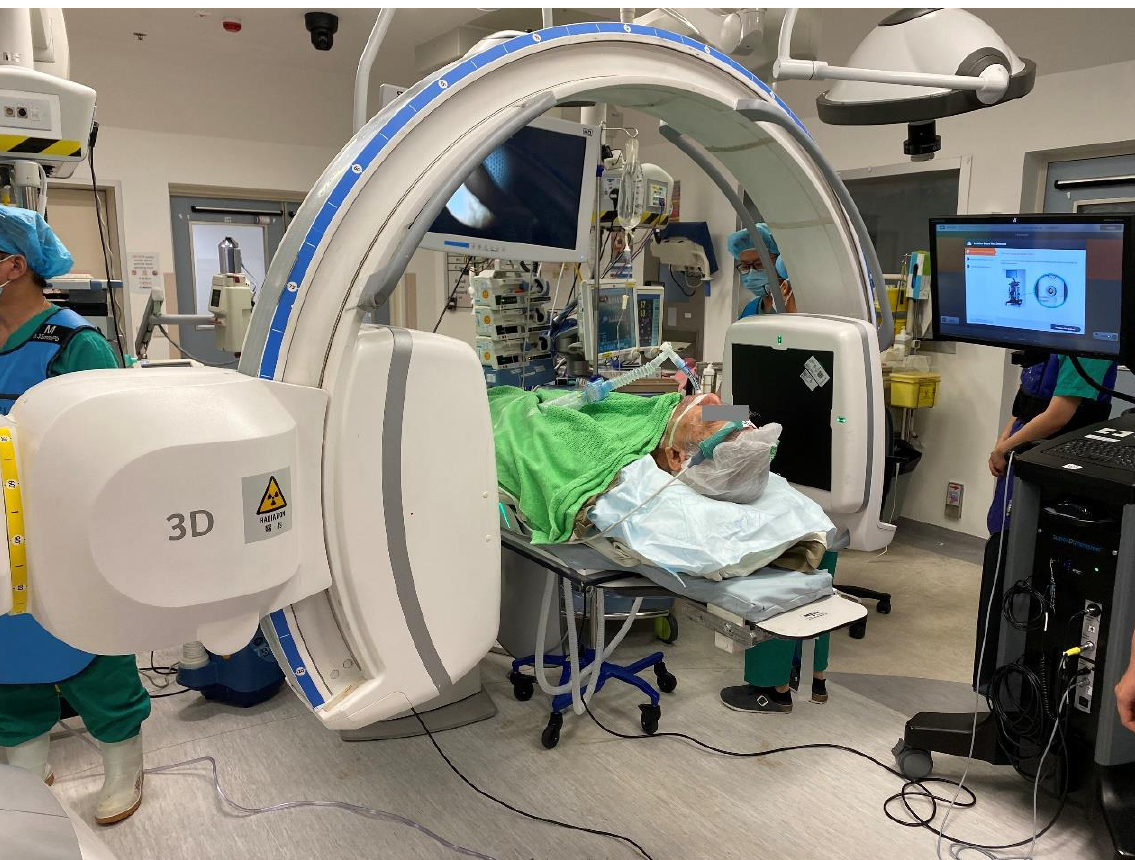
Figure 3. Picture of the operating room setup during Cios Spin ® mobile C-arm image acquisition.